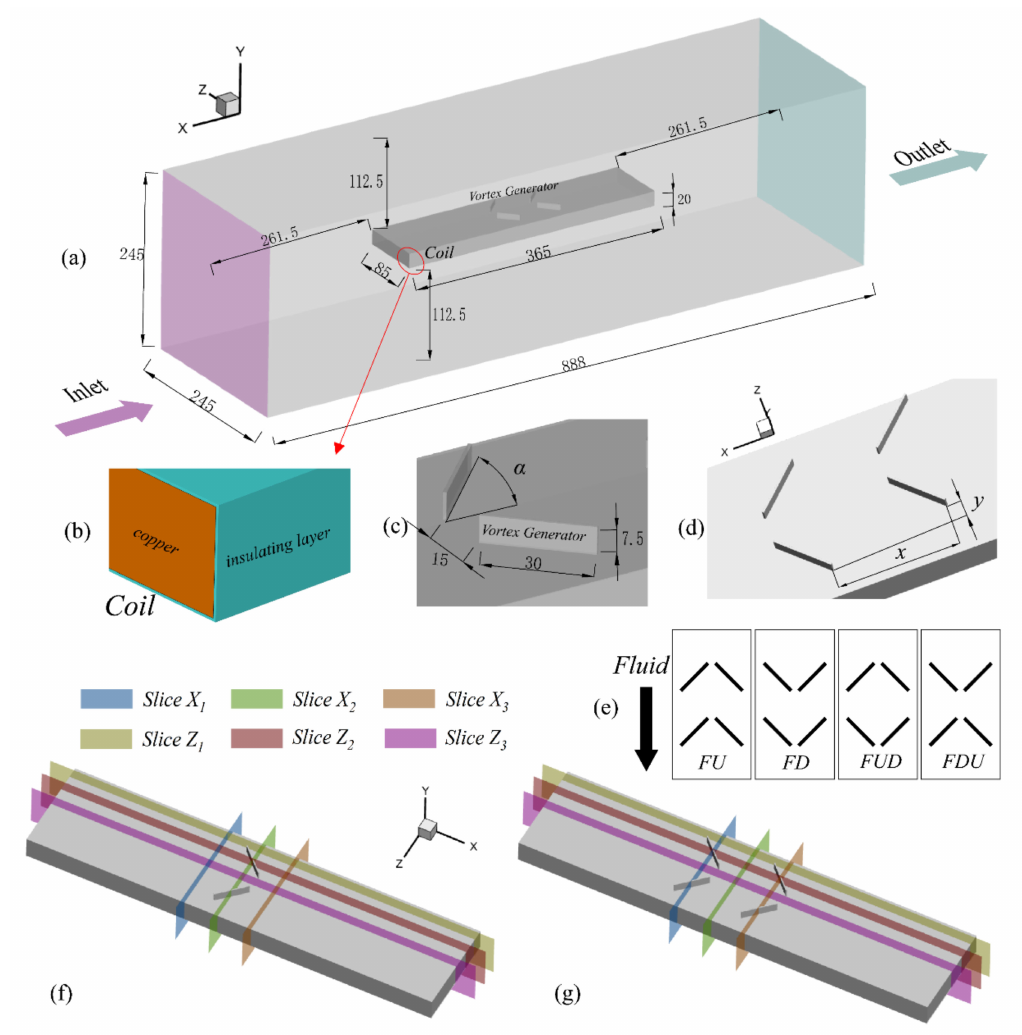
Figure 1. ( a ) Diagrams of a channel with coil and vortex generators, ( b ) specific graph of the coil, ( c , d ) specific graphs of vortex generator, ( e ) four different distribution types, ( f , g ) slice diagrams in X and Z